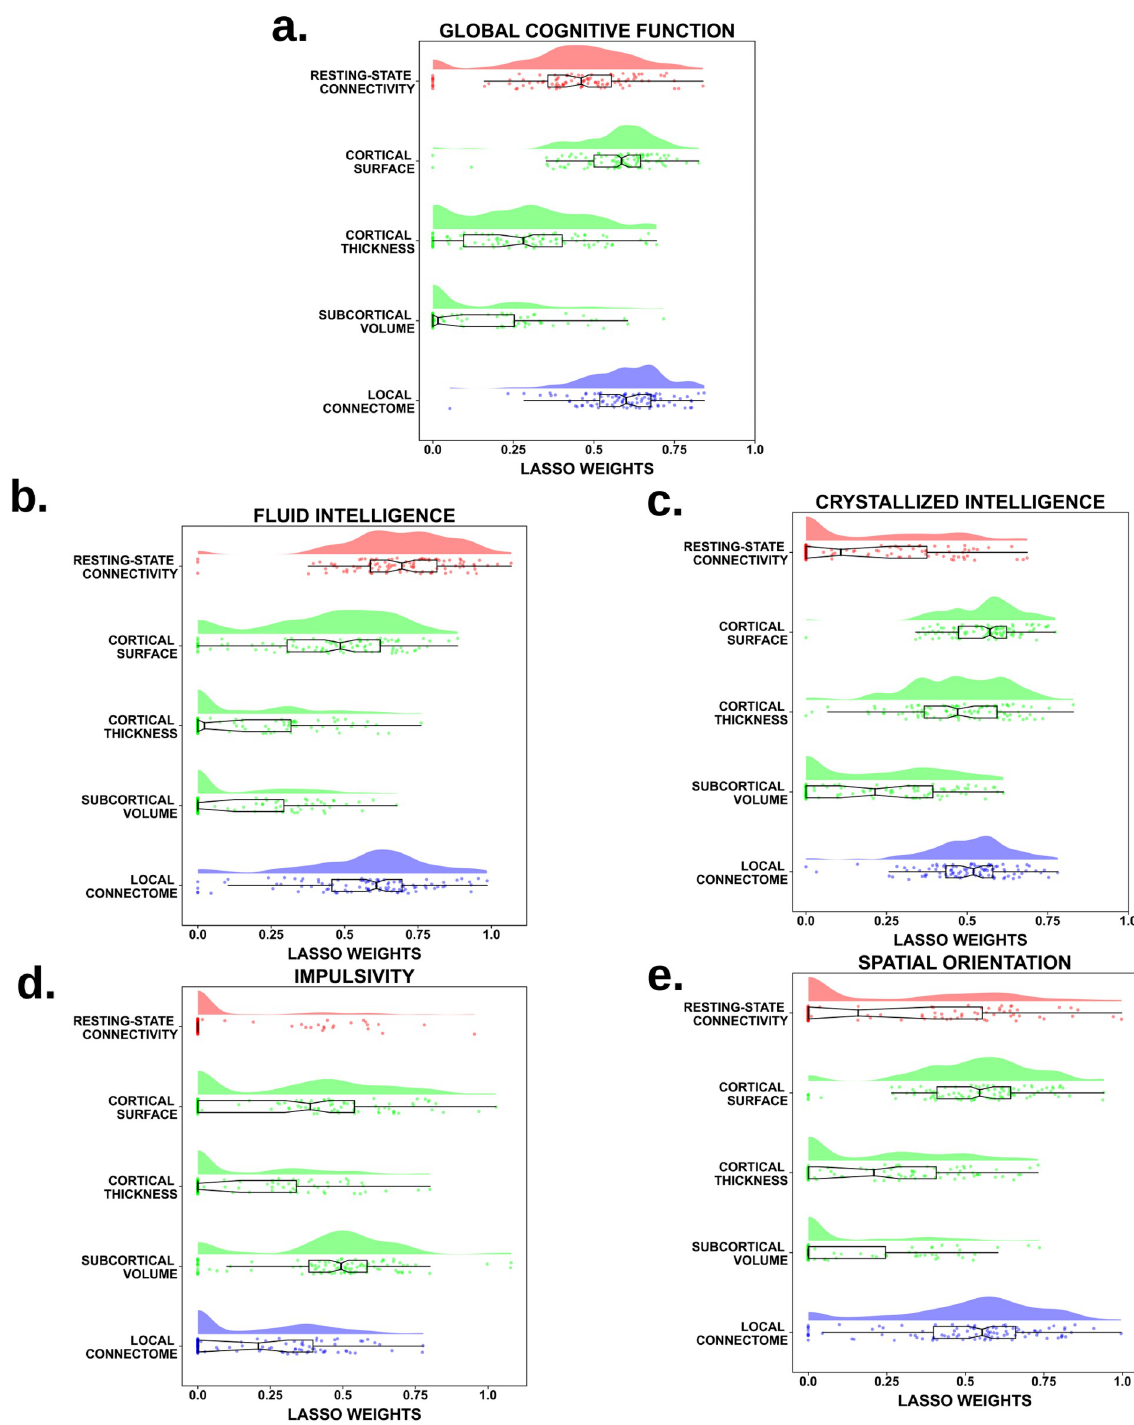
Fig 3. Regression coefficient distribution of each single-channel in the stacked model. Across the 100 different data splits, the weight distribution assigned to the out-of-sample predictions of each brain measurement by the stacked LASSO model in those cognitive scores in which stacking significantly improved the overall